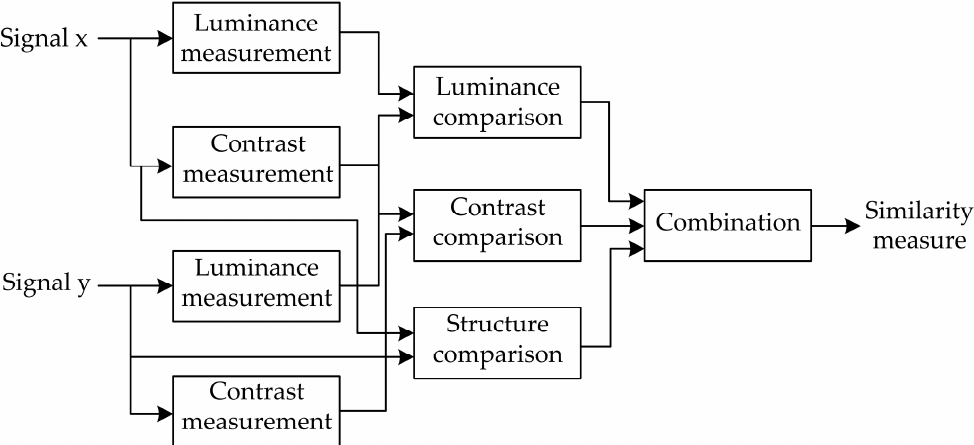
Figure 1. The block diagram of the SSIM index metric.